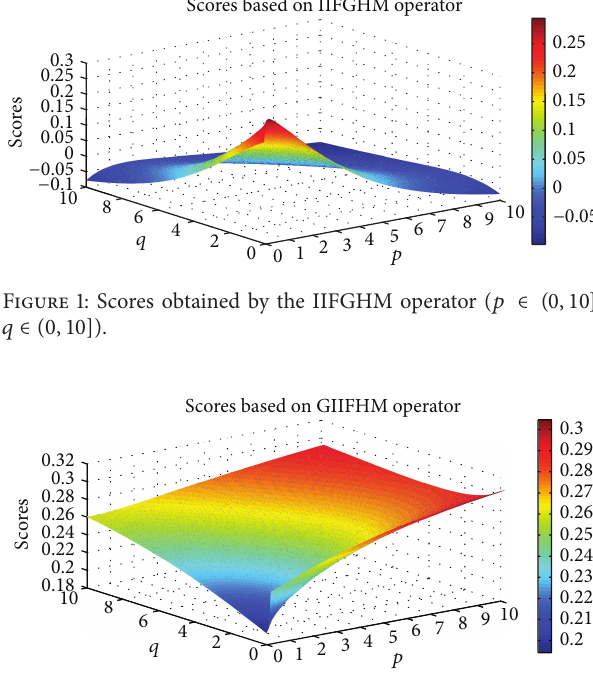
Figure 2: Scores obtained by the GIIFHM operator ( 𝑝 ∈ (0, 10] , 𝑞 ∈ (0, 10]